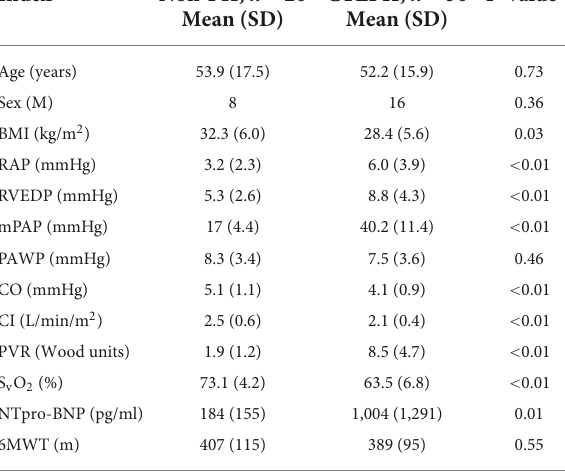
TABLE 1 Baseline variables between those with and without pulmonary hypertension.